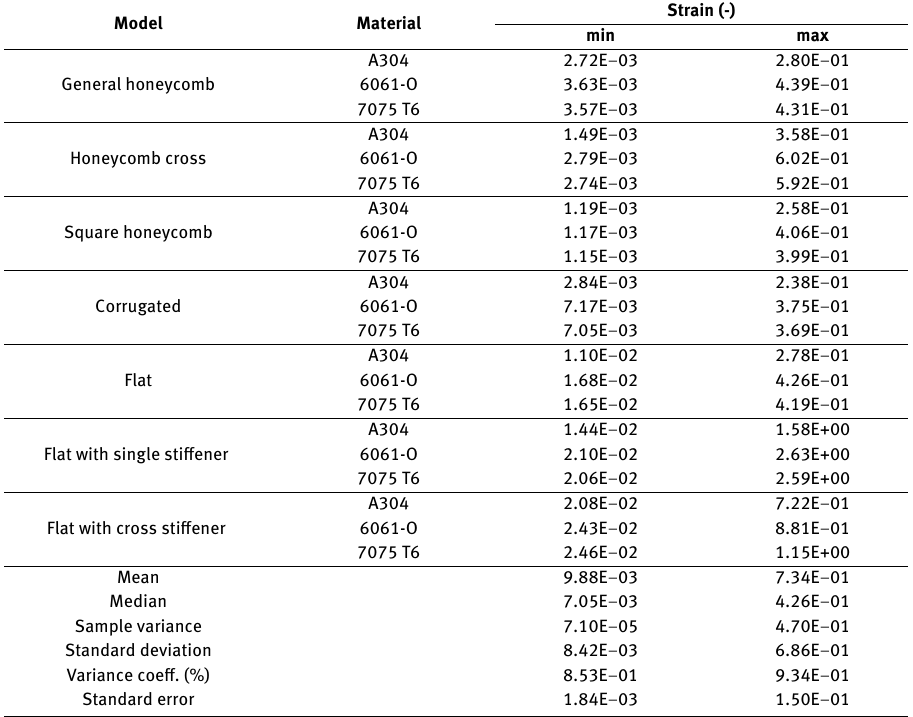
Table 5: Summary of the strain results